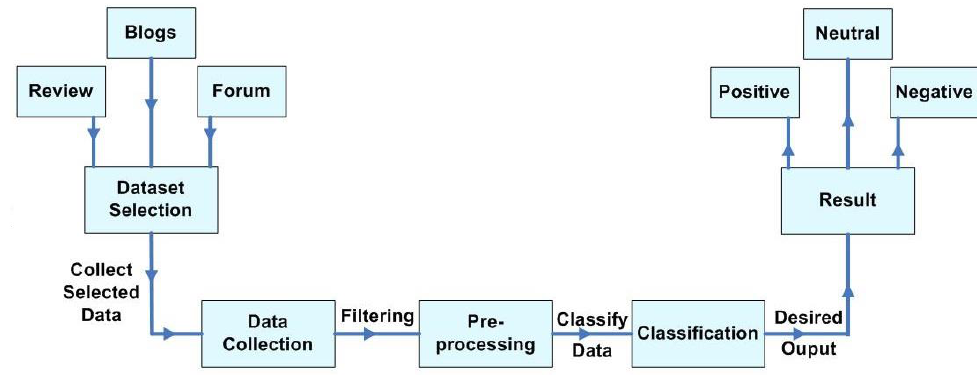
Figure 6. General opinion-mining steps. Table 1. Keywords used search terms. Keyords — Italian/English